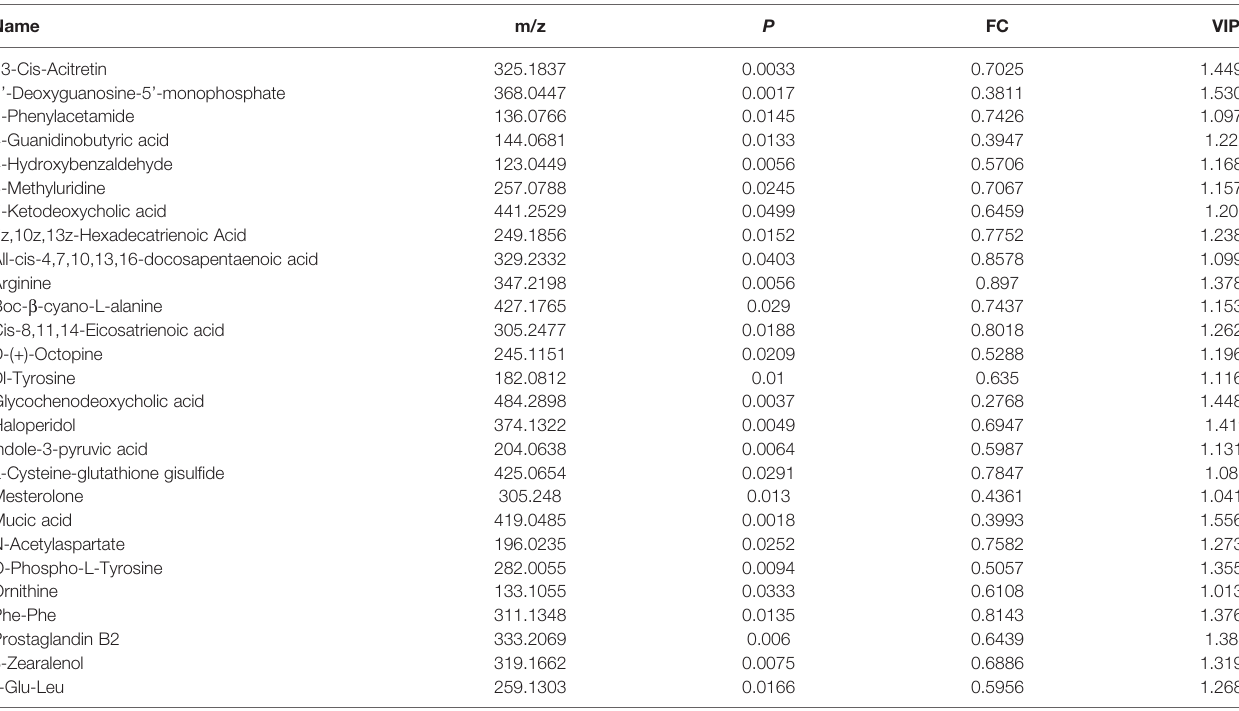
*This table didn ’ t list fi ve exogenous compounds, namely, diazepam, diltiazem diacetate, di fl unisal, oxfendazole, di fl unisal.